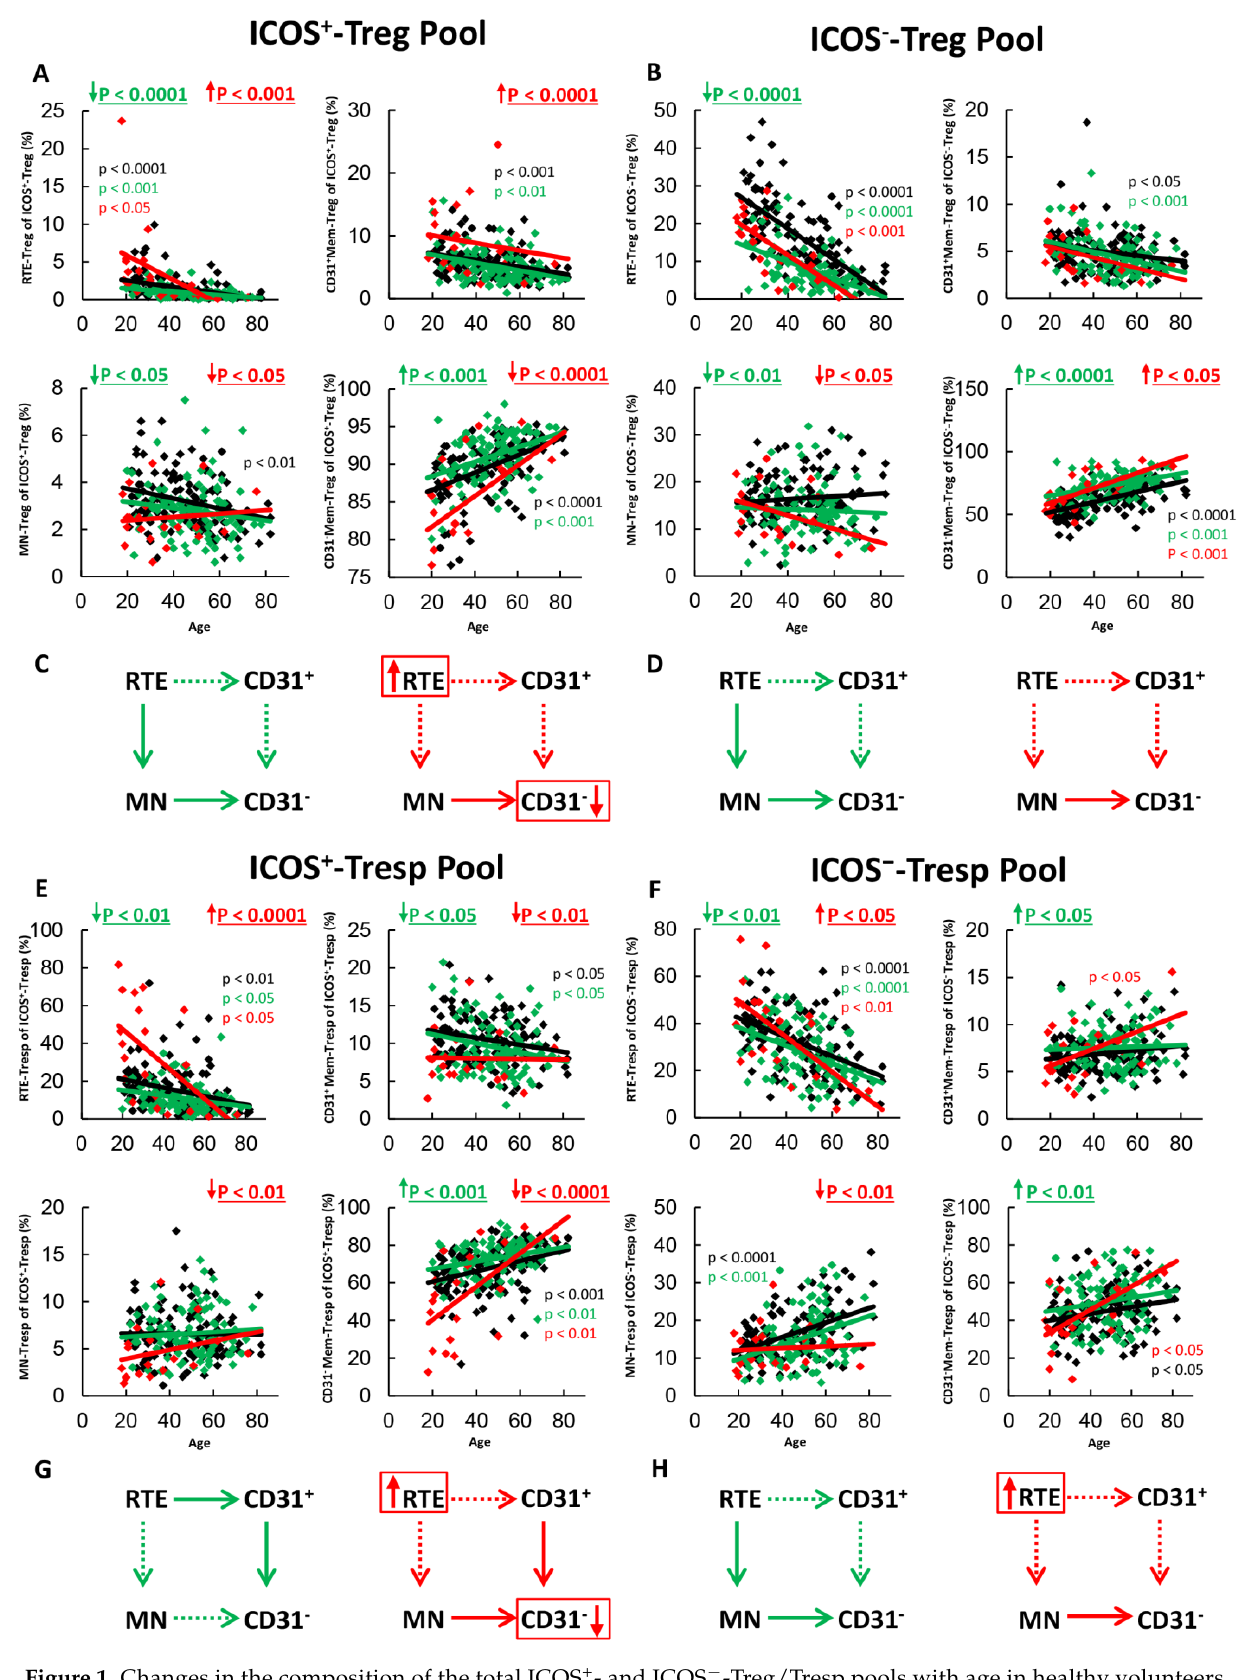
Figure 1. Changes in the composition of the total ICOS + - and ICOS − -Treg/Tresp pools with age in healthy volunteers, SLE patients in remission and SLE patients with active disease. The percentage of RTEs, MNs, CD31 + -memory cells